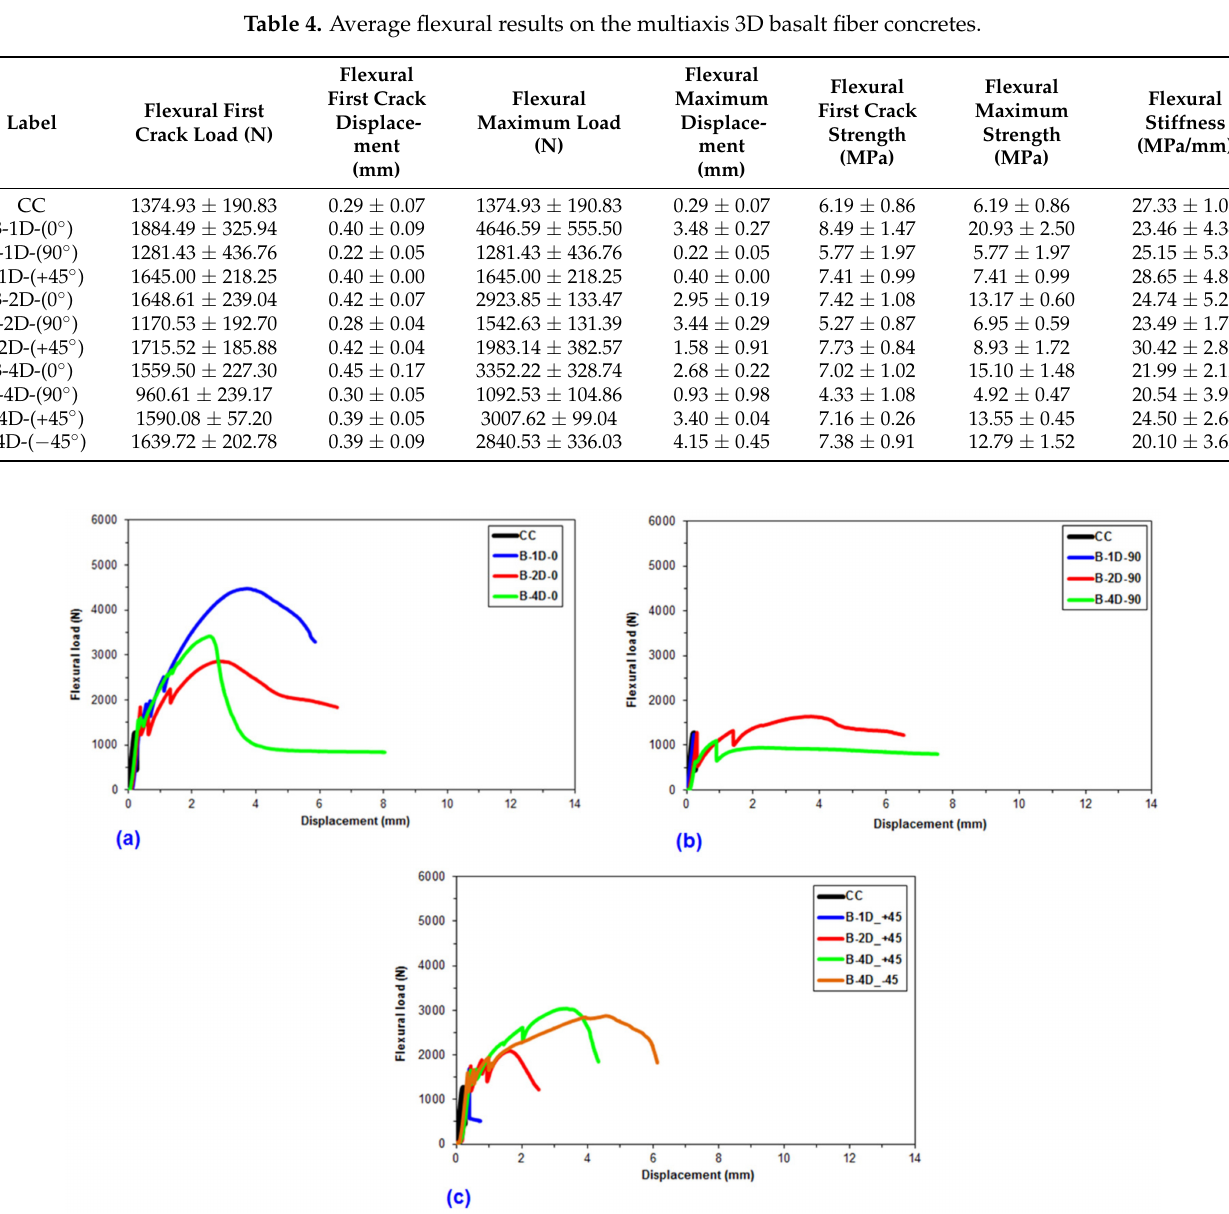
Table 4. Average flexural results on the multiaxis 3D basalt fiber concretes.